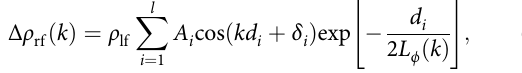
¼ 4 ae , d ¼ 2 a 1 þ e ð Þ and d 3 = 4 a . 1 2 ¼ δ ¼ δ þ δ þ π , δ and 1 f 2 f c 4